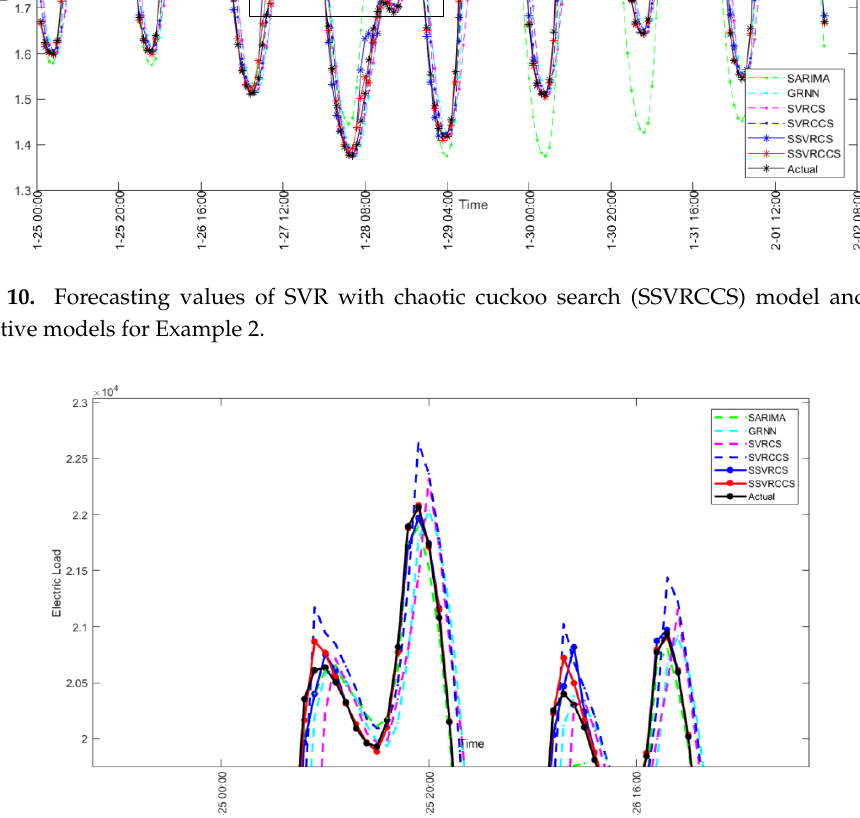
Figure 13. The enlargement comparison of Peaks 5 and 6 from the compared models for Example 2.